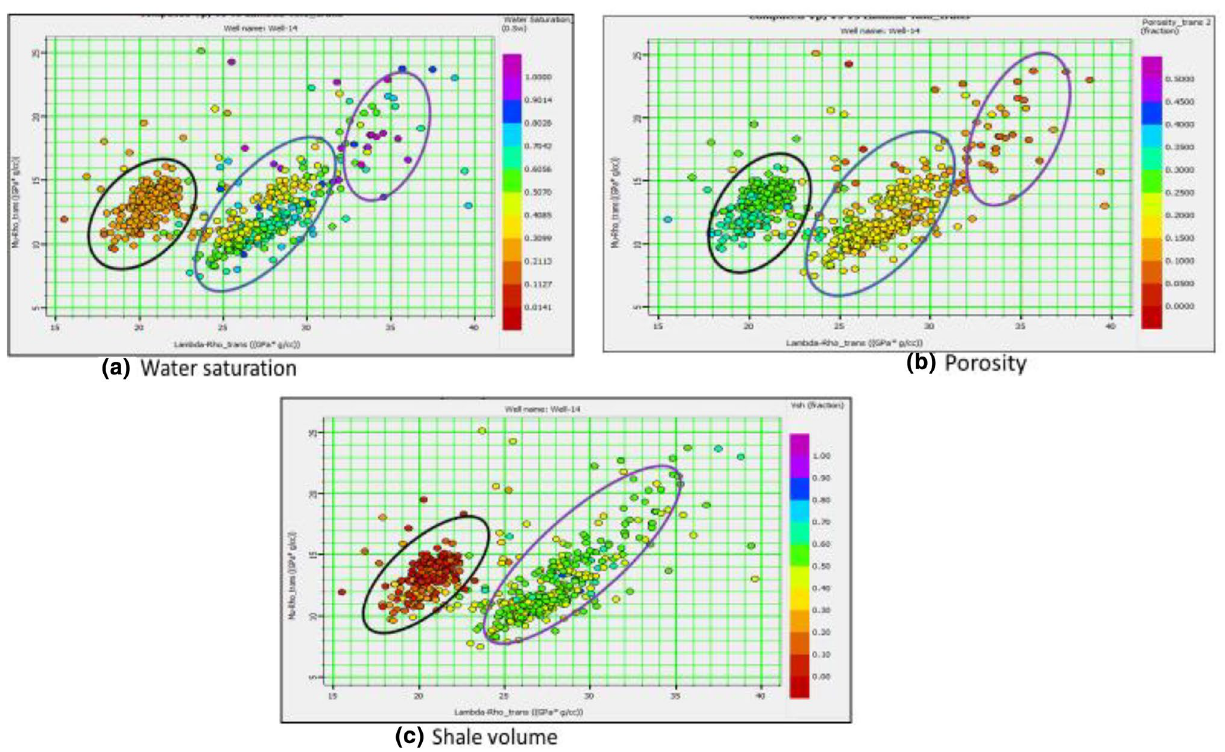
Fig. 7 Cross-plots of mu–rho ( µρ ) versus lambda–rho ( λρ ), color coded with a water saturation, b porosity and c shale volume for SAND 4